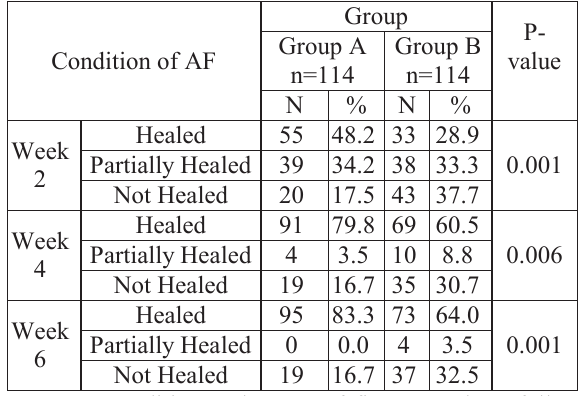
Table-3: Condition and status of fissure at three follow up times in both groups